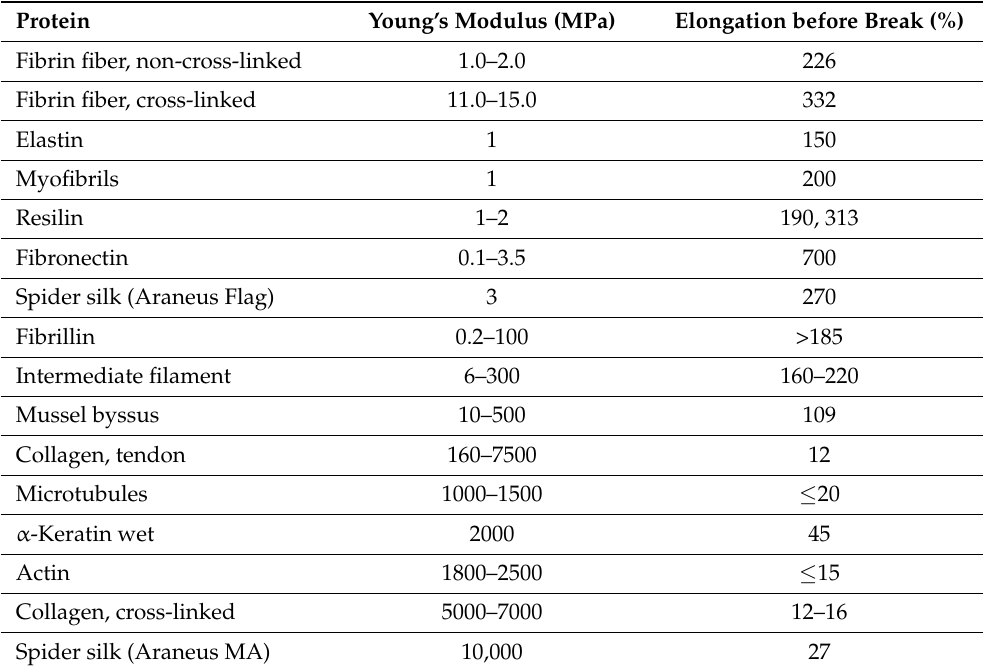
Table 3. Mechanical properties of various protein fibers in comparison with fibrin. Com- piled from Ref.